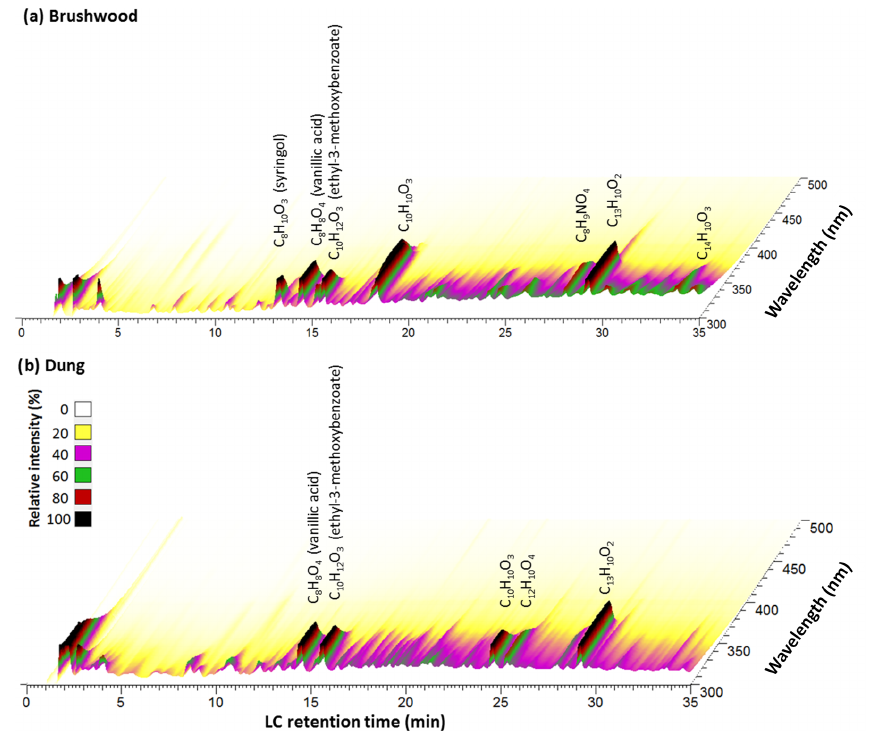
Figure 9. HPLC-PDA chromatogram showing BrC chromophores detected in the emission samples from (a) brushwood and (b) dung cook fires. Highly absorbing molecules and their corresponding PDA retention times are given above the